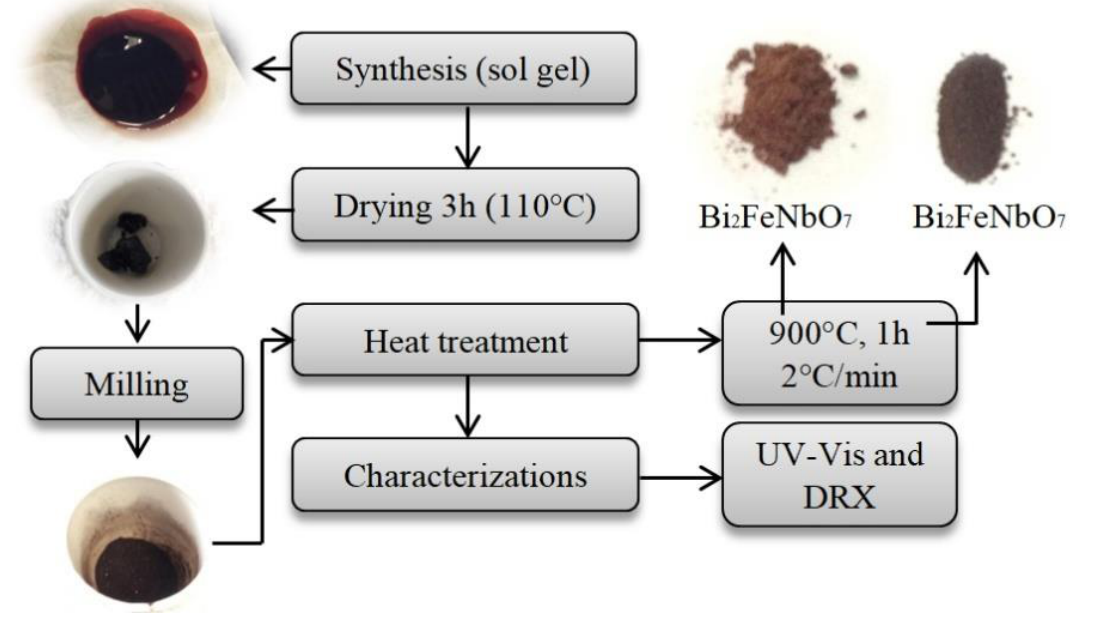
Figure 2. Research methodology